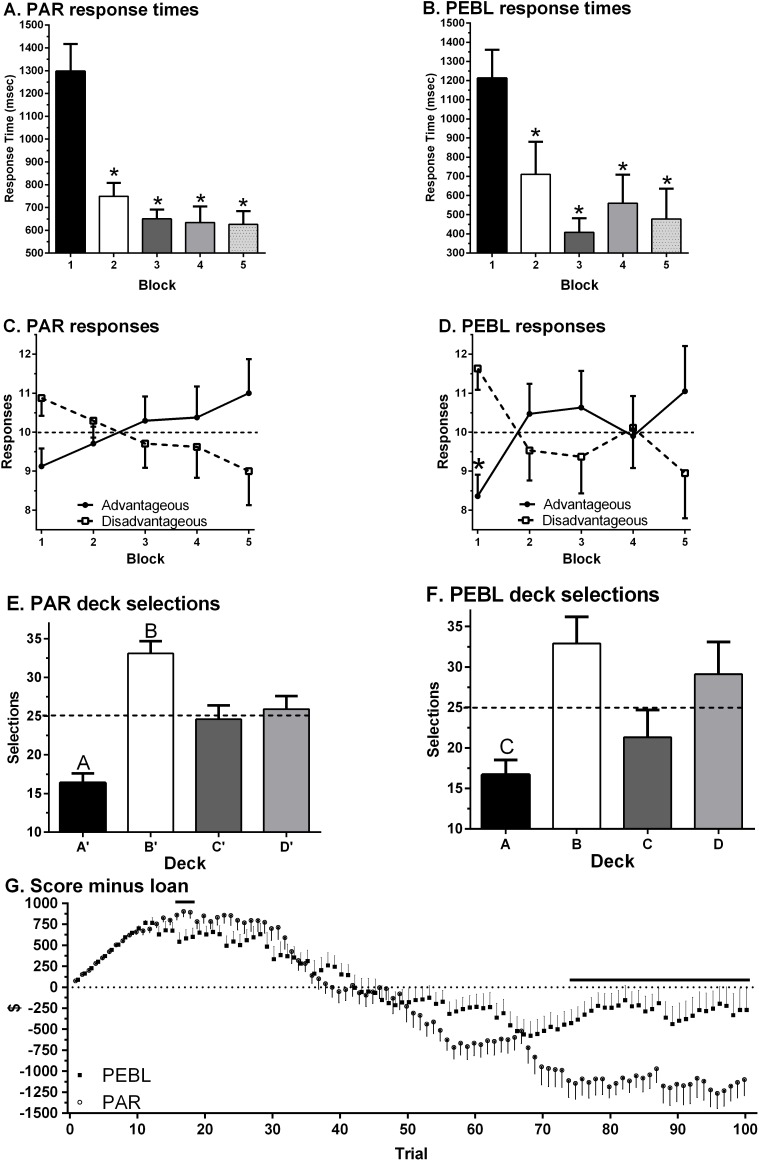
Response times on the Psychological Assessment Resources (PAR, A) and Psychology Experiment Building Language (PEBL, B) Iowa Gambling Task by block of 20 trials (∗p < .0005). Selection of advantageous and disadvantageous decks (C, D) (∗p < .05 versus disadvantageous on block 1). Selection of each deck (E, F) (Ap < .005 versus Deck B, C, or D; Bp < .05 versus Deck C and D; Cp < .05 versus Deck B). Compensation by trial (G) (horizontal line indicates p < .05).